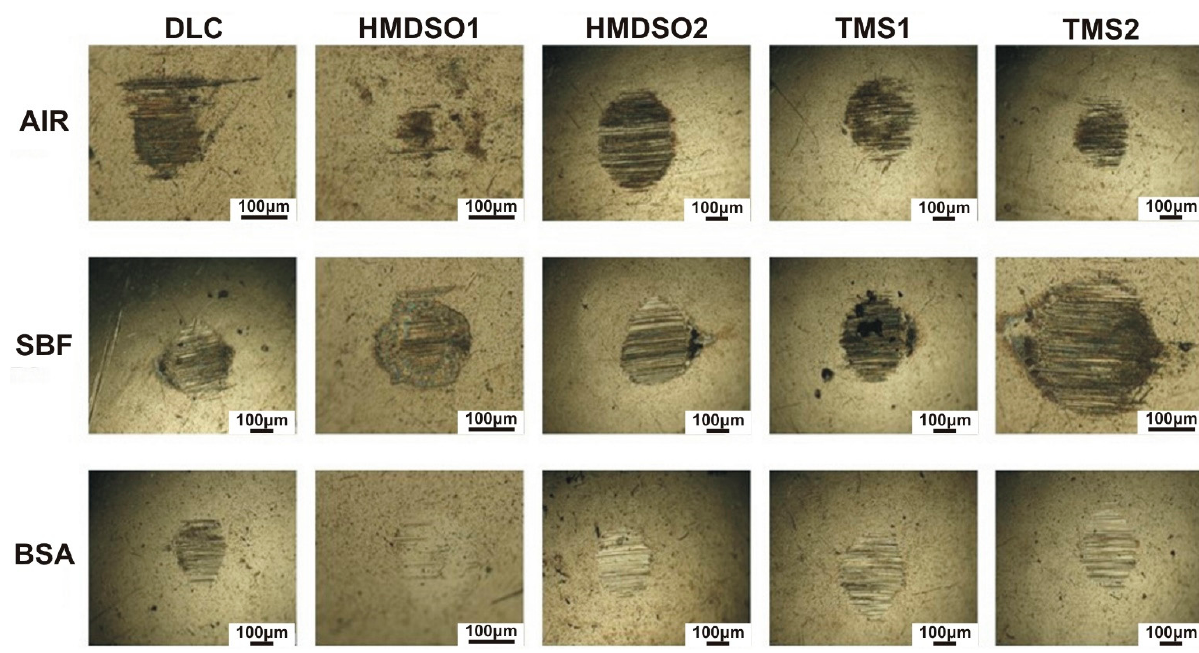
Figure 4. Wear scars on the AISI316L counterbody tested with DLC and silicon-incorporated DLC coatings in different environments. The scale bar length on all images is 100 µm.